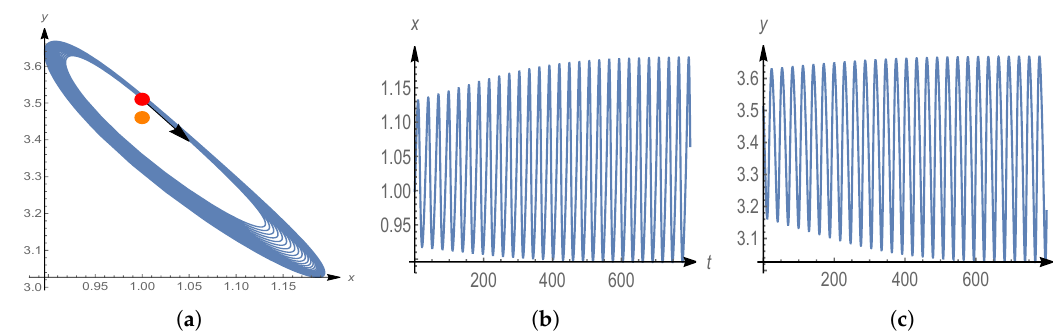
Figure 13. Model 2 with a stable outer and an unstable inner limit cycle. The trajectory is going outward, approaching the outer limit cycle as t → ∞ and the inner limit cycle as t → − ∞ ( d = 0.05).